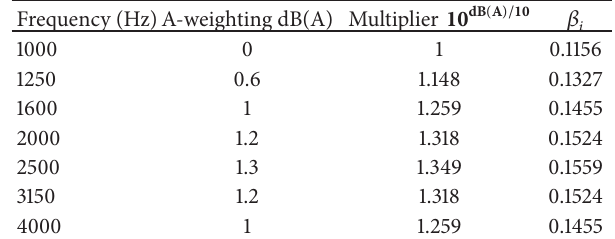
Table 3: Normalized weights using the A-weighting.